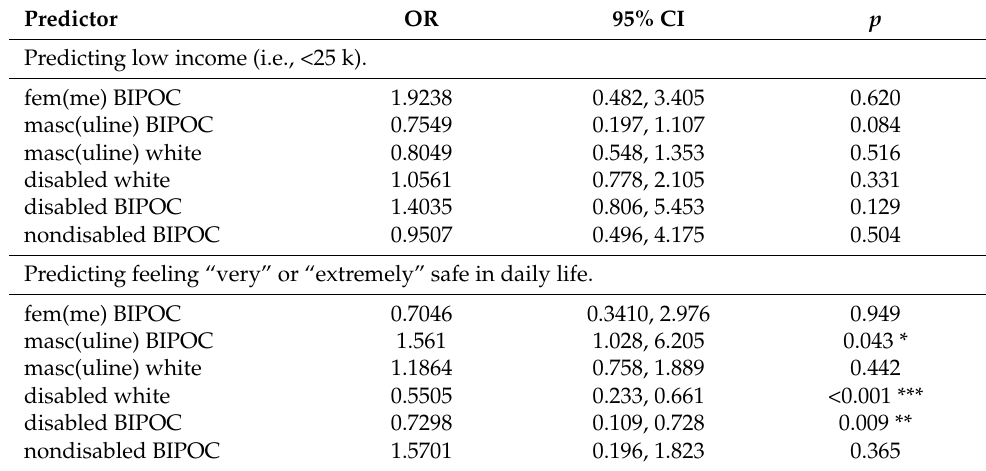
Table 7. Predicting odds ratios for subgroups. Predictor OR 95% CI